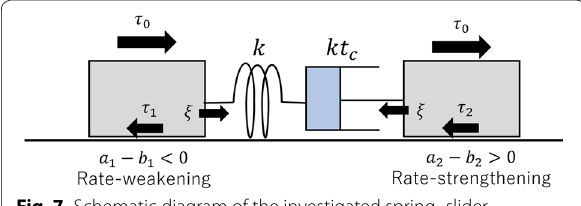
Fig. 7 Schematic diagram of the investigated spring–slider– dashpot model. Two blocks representing rate-weakening and rate-strengthening patches are connected by a Maxwell element composed of a spring of stiffness k and a dashpot of viscosity kt c